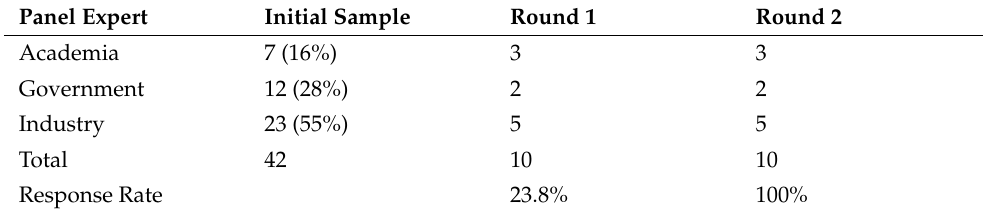
Table 5. Number of